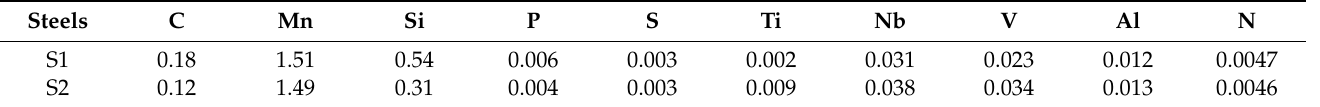
Table 1. Chemical composition of the experimental steels